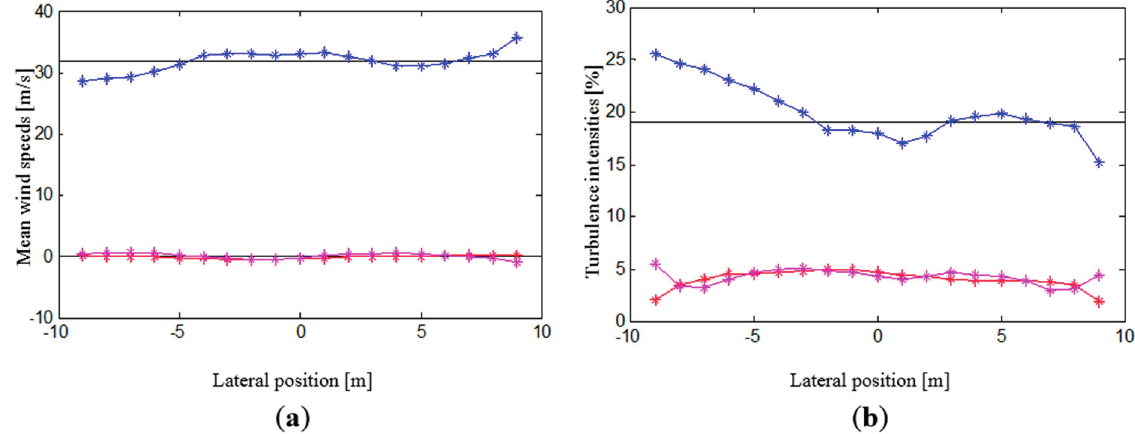
Figure 5. Horizontal profile of mean wind speeds ( a ) and turbulence intensities ( b ). Blue: u -component, red: v -component; purple: w -component.